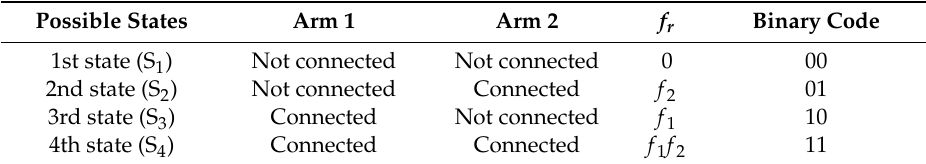
Figure 5. Four possible states for the single proposed resonator: ( a ) S 1 (no frequency), ( b ) S 2 ( f 2 only), ( c ) S 3 ( f 1 only), and ( d ) S 4 ( f 1 and f 2 ).